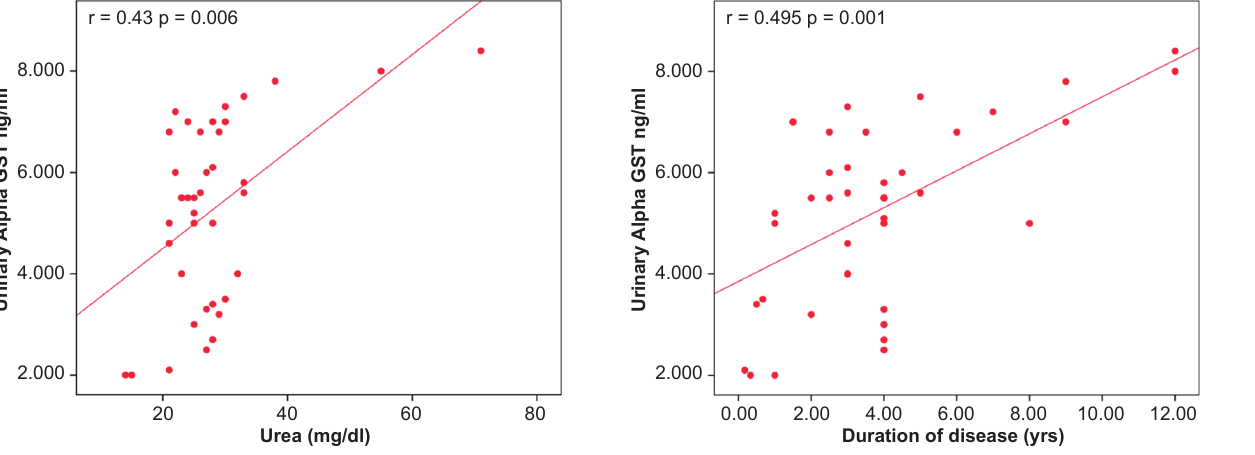
Figure 5. Correlation between urinary alpha glutathione S-transferase and duration of nephrotic